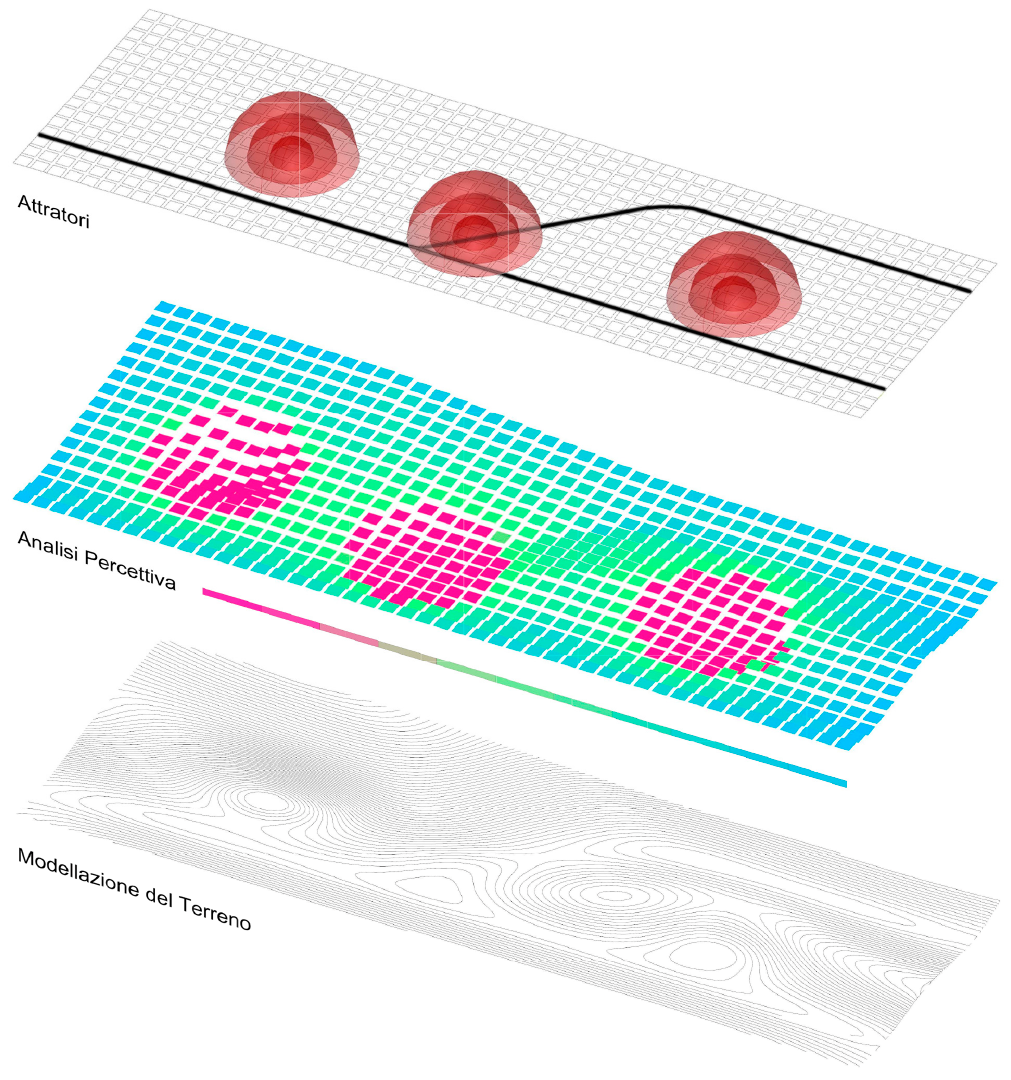
Figure 7. Perceptual analysis process at the base of terrain modeling by the use of attractors.